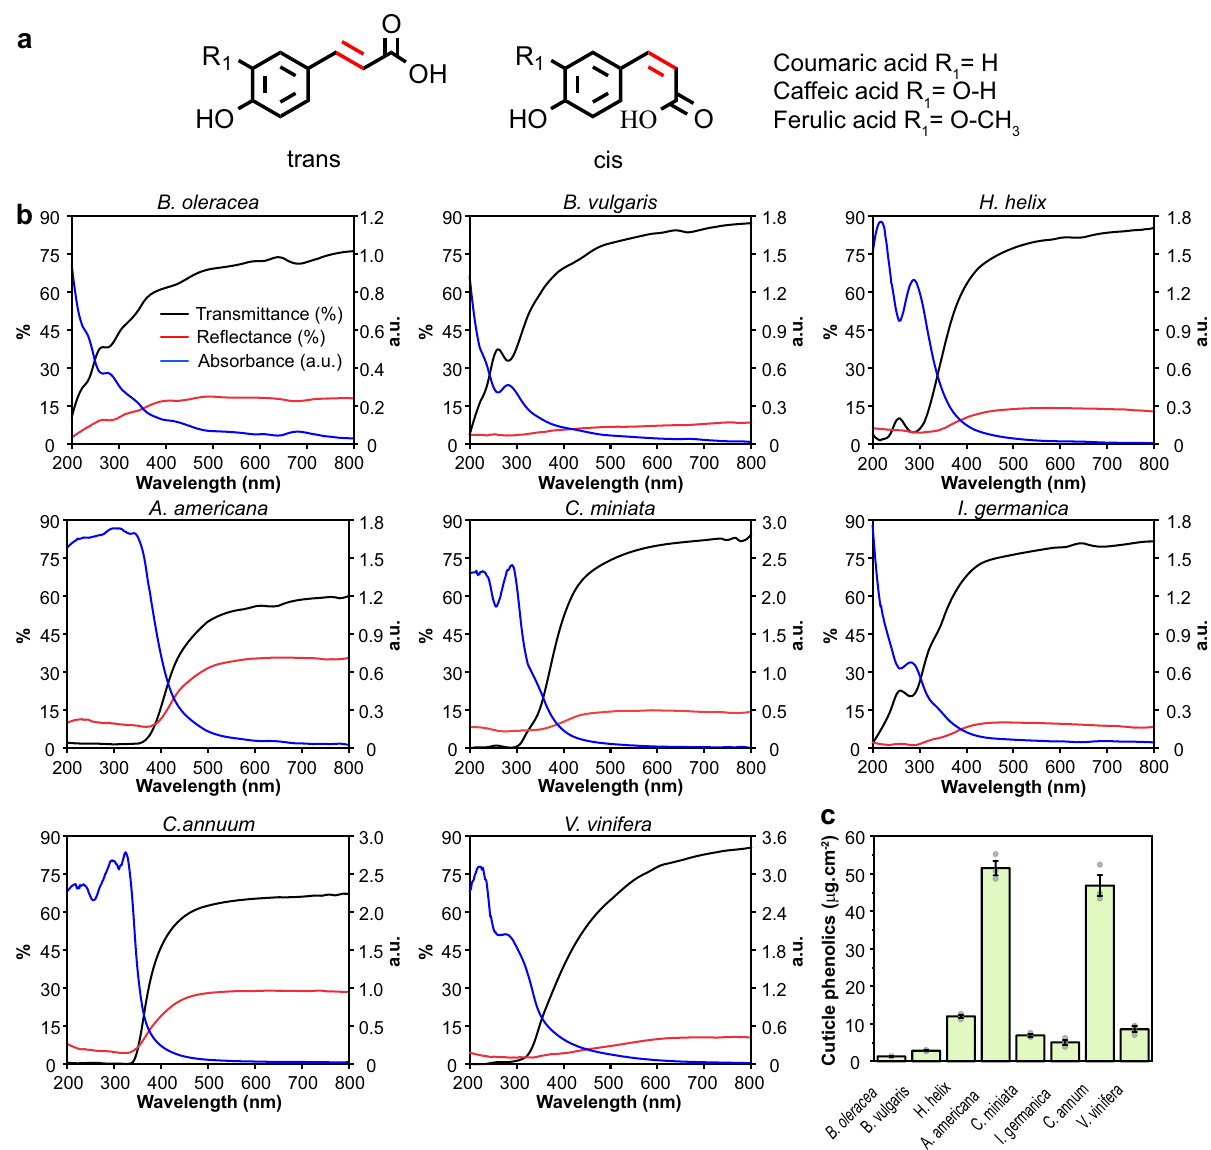
Fig. 1 Cuticle phenolics and optical properties associated with the cuticle. a Trans and cis chemical structure of cinnamic acids. In red the double bond is responsible for the trans - cis isomerization. To the right, substituents of the different cinnamic acids reported for cuticles of various species are indicated. b Transmittance, re fl ectance and absorbance spectra of isolated cuticles from different species. Brassica oleracea , Beta vulgaris , Hedera helix , Agave americana , Clivia miniata and Iris germanica leaf cuticles. Capsicum annuum and Vitis vinifera fruit cuticles. n = 4 biologically independent samples. c Amount of cuticle phenolics per surface unit. Data were represented as means ± s.e. n = 3 biologically independent